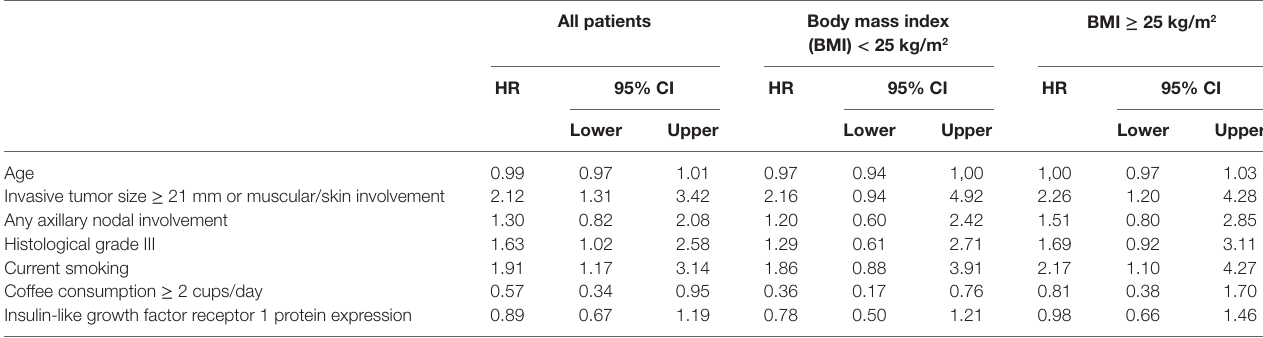
TaBle 4 | Multivariable analysis of risk of breast cancer events in radiotherapy-treated patients irrespective of tumor ER status (n =